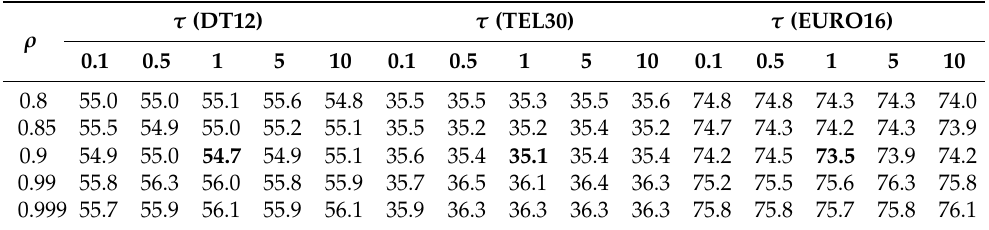
Table 5. Results of tuning process—an average value of objective function ( z ) for different values of initial temperature coefficient ( τ ) and cooling rate ( ρ ) in analyzed networks; best values marked in